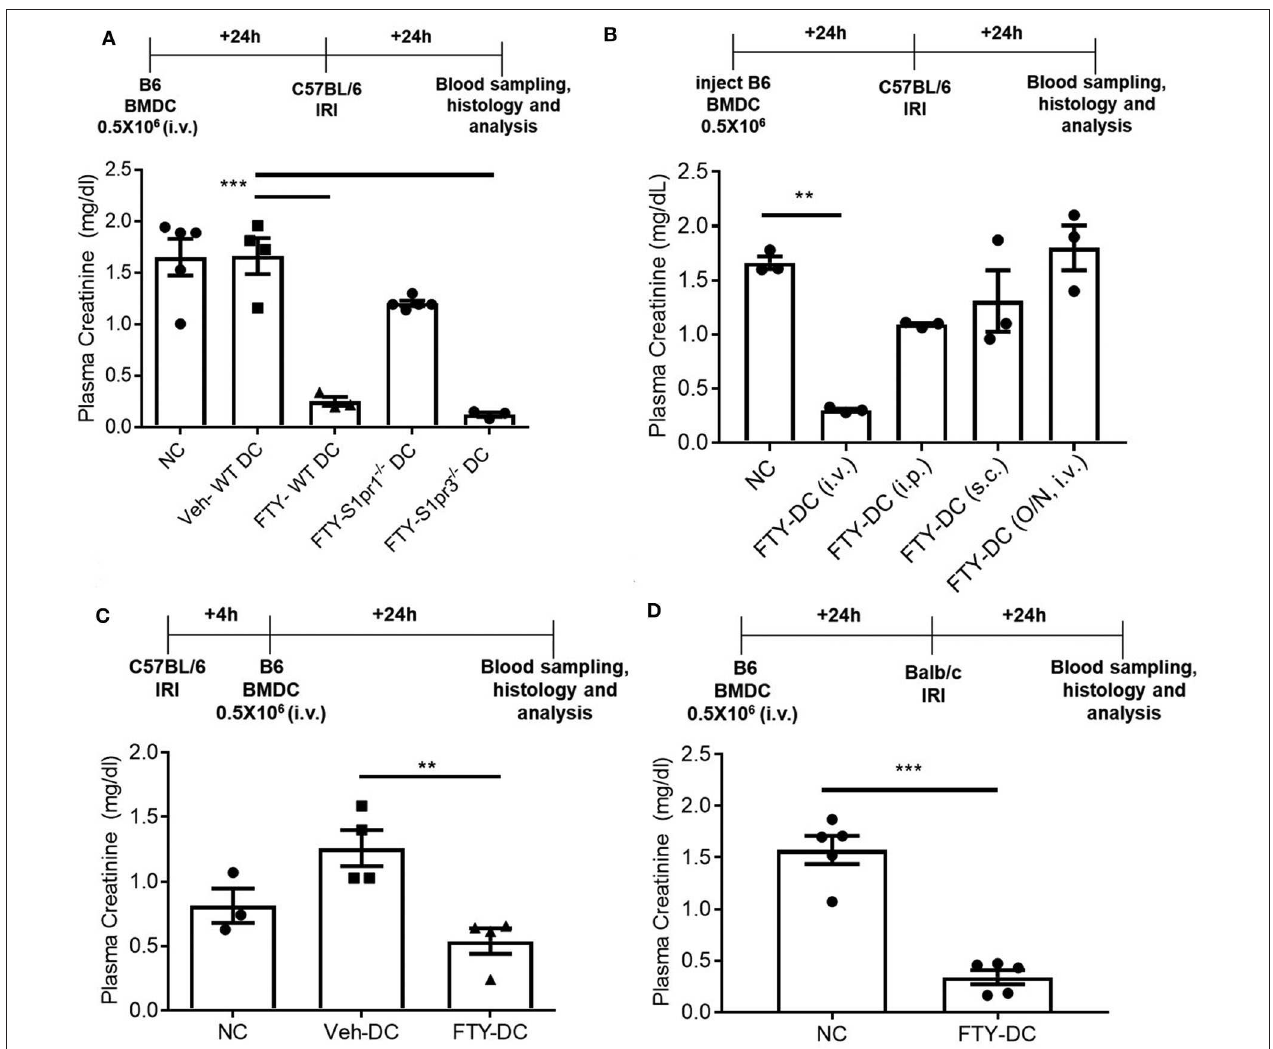
FIGURE 5 | FTY-DC require S1pr1 on BMDC to protect kidneys from IRI. (A) Protocol for experimental setup. FTY720 is a ligand for four out of five S1P receptors. Plasma creatinine (PCr, mg/dL) was measured 24h after IRI. We tested if S1pr1 or S1pr3 were requited for FTY720 dependent regulatory DC phenotype. BMDCs were propagated from either C57BL/6 WT, CD11cCreS1pr1 fl / fl ( S1pr1 − / − DC), or S1pr3 − / − and treated with FTY720. FTY- S1pr1 − / − DC do not protect kidneys